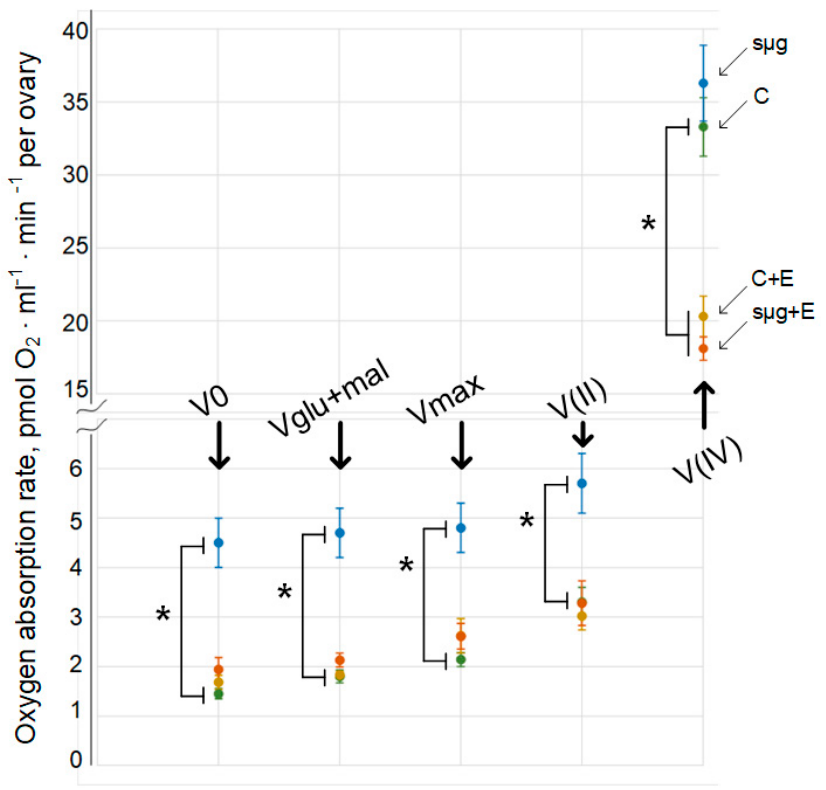
Figure 1. Respiration rate in ovaries after exposure to simulated microgravity conditions during the full cycle of oogenesis. C—control group, green line; sµg—fly group that had undergone the full cycle of oogenesis under simulated microgravity, blue line; C + E—control group that received essential lipids per os (500 mg per 1 kg medium), yellow line; sµg + E—fly group that received essential phospholipids and had undergone the full cycle of oogenesis under simulated microgravity, red line. V0—respiration rate of permeabilized cells; Vglu + mal—respiration rate after adding 10 mM glutamate + 5 mM malate; Vmax—maximum respiration rate after adding 2 mM ADP; V(II)—respiration rate after adding 0.5 µM rotenone (complex I inhibitor) and subsequent supplementation with 10 mM succinate (substrate of complex II); V(IV)—respiration rate after adding 5 µM antimycin (complex III inhibitor) and subsequent supplementation with 0.5 mM TMPD + 2 mM ascorbate (artificial substrates of complex IV). * p < 0.05 in comparison with the control group.